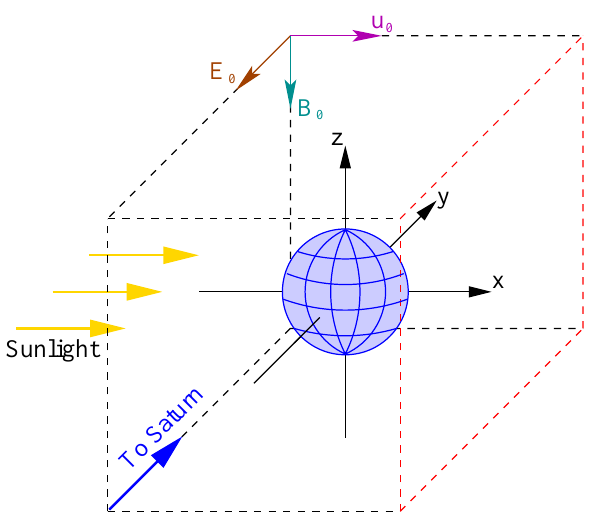
Fig. 4. Plasma environment of Titan – Simulation geometry. The dayside of the obstacle is located in the (x< 0 ) hemisphere. The undisturbed plasma flow is directed parallel to the (+x)-axis, whereas the undisturbed Saturnian magnetic field is perpendicular to Titan’s orbital plane, pointing in ( − z)-direction. When Titan is located inside Saturn’s magnetosphere, the y-axis is pointing to- wards Saturn. The boundary layer denoted by the red lines is located in Titan’s wake region. In this geometry, the (x,y) plane of the co- ordinate system coincides with Titan’s equatorial plane, whereas the polar plane is identical to the (x,z) plane. This situation differs from the Martian simulation geometry displayed in Fig.